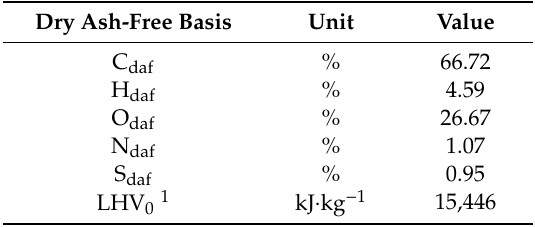
Table 1. Ultimate analysis of Huolin River lignite.